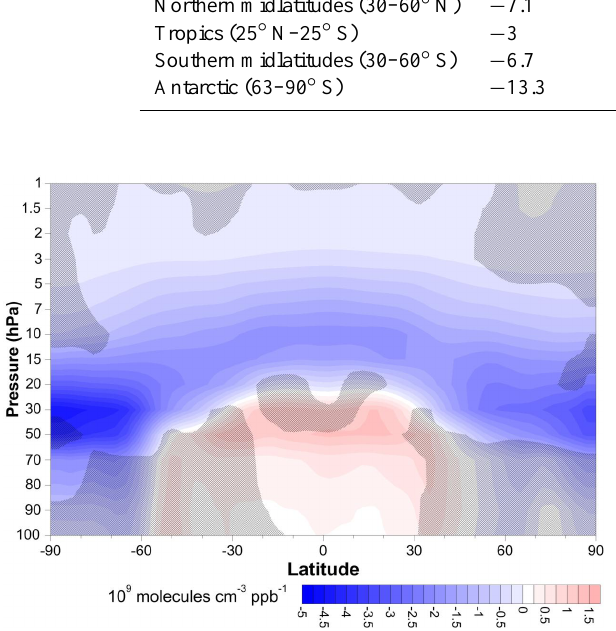
Figure 10. Similar to Fig. 9, but the slopes are from simple linear regression models fitted to 2 Fig. 10. Similar to Fig. 9, but the slopes are from simple linear re- 2090s-mean ozone vs. 2090s-mean surface CH 4 for the four CH 4 simulations. 3 gression models fitted to 2090s-mean ozone vs. 2090s-mean surface CH 4 for the four CH 4